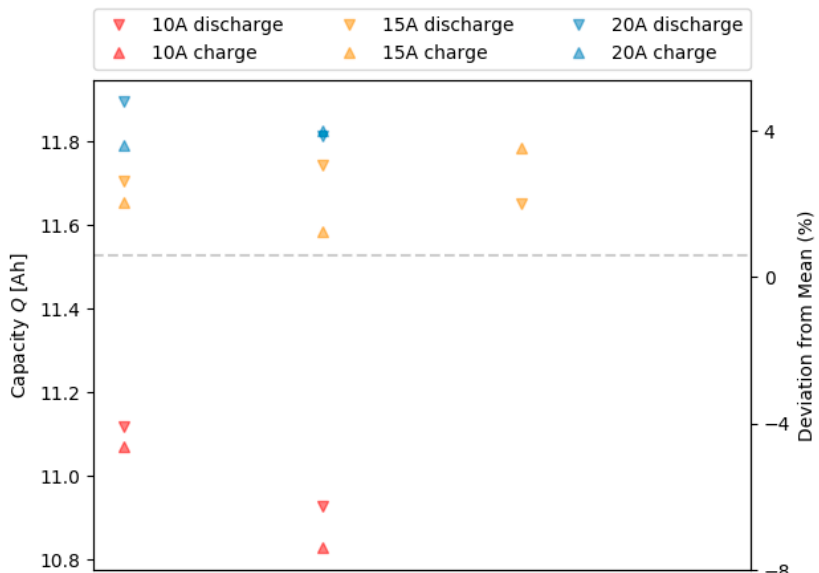
Figure 7. Capacity at charge (up-pointing triangles) and discharge (down-pointing triangles) for three levels of current (all tested at module C).